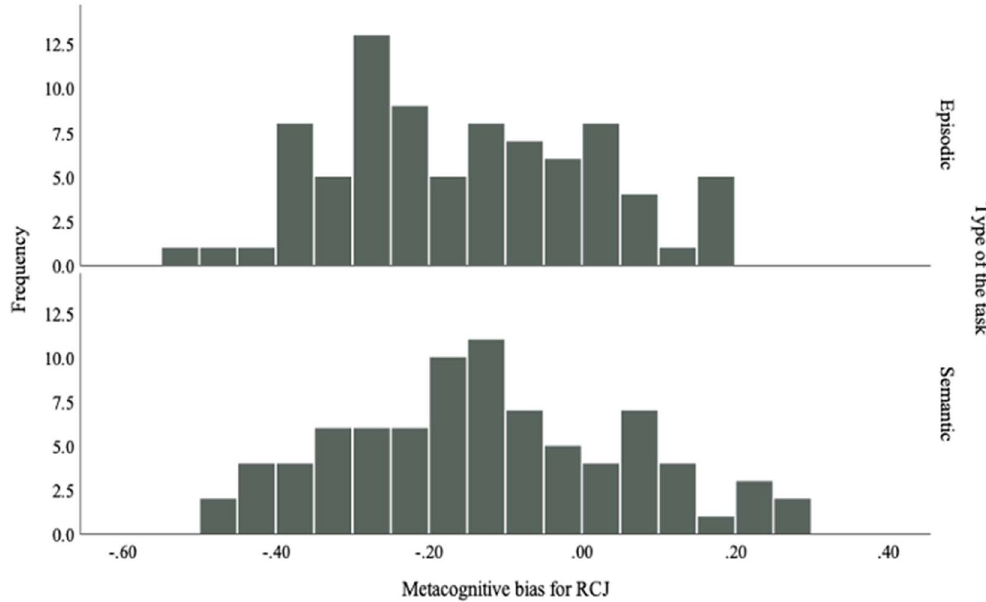
Figure 2. Metacognitive sensitivity during RCJ phases of episodic and semantic memory